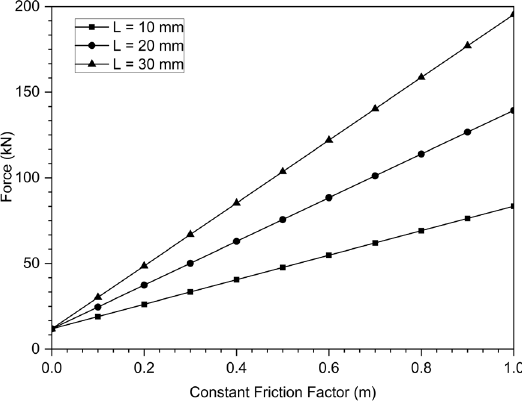
Figure 7. Effect of the friction factor on the maximum ECAP forces for different billet